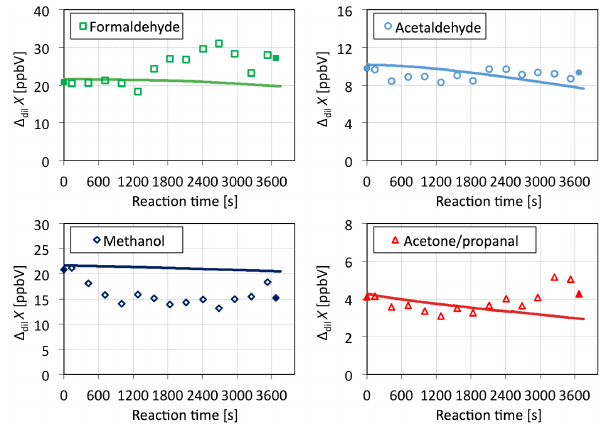
Figure 8. Dilution-corrected molar excess mixing ratios of furan and 2-furfural during 1h of plume evolution. Point symbols refer to the measured data (1km bins); solid lines represent the output of the UWCM fed with MCM v3.3 chemistry.